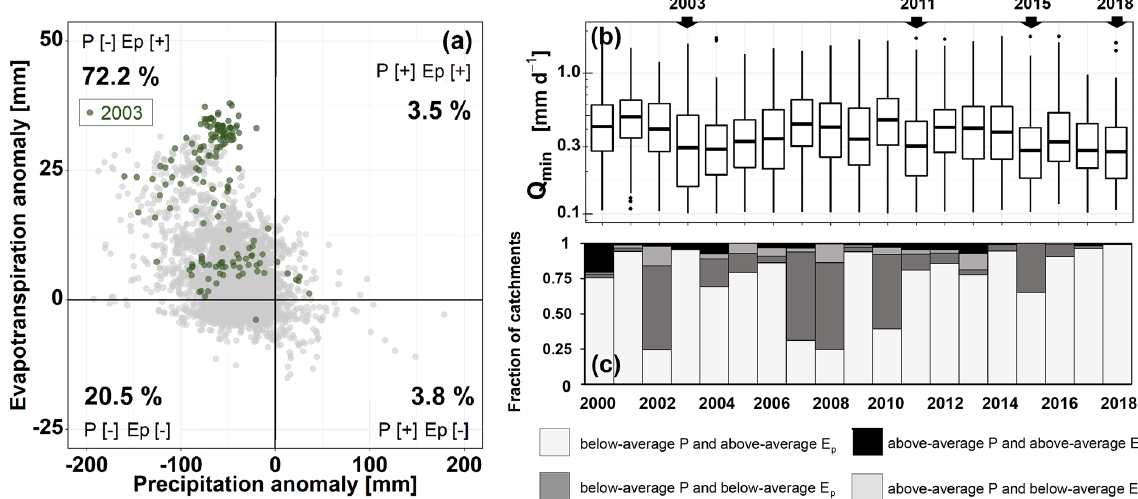
Figure 3. Anomalies in precipitation and potential evapotranspiration 30d prior to each annual warm-season (May through November) low-flow period in each catchment (gray dots); annual cold-season low flows were excluded (a) . The most severe low-flow year during the study (2003) is highlighted in green. Almost all (92.7%) annual low flows occurred following below-average precipitation; see the left half of panel (a) . A total of 72.2% of all low flows occurred following a combination of below-average precipitation and above-average potential evapotranspiration; see the upper left quadrant of panel (a) . Box plots of warm-season 7d minimum flows for the Swiss study catchments (b) , and the catchment distribution of the signs of precipitation and evapotranspiration anomalies that preceded these low flows (c) . The most severe low-flow years (2003, 2011, 2015 and 2018) were characterized by negative precipitation anomalies and positive E p anomalies for the vast majority of catchments, as indicated by the light gray bars in (c)